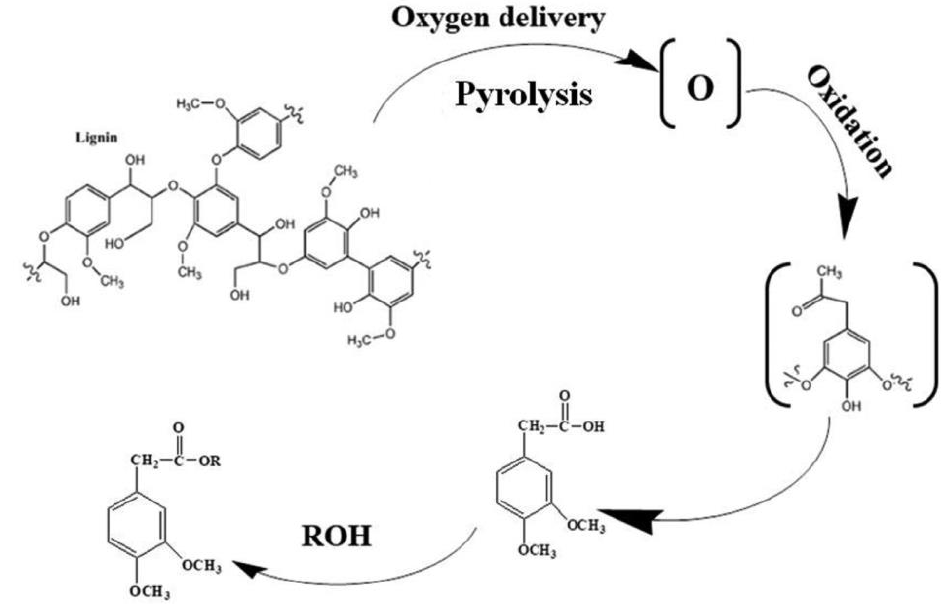
Figure 3. Esterification of lignin. Reproduced from [94], with the permission of Elsevier. Xing et al. [35] reported the esterification of soda lignin with 10-undecenoyl chloride and oleoyl chloride, carried out at 65 ◦ C for 48 h without additional use of solvents or catalysts. At the end of the reaction, methanol was added to the reaction to quench unreacted chlorides. After the removal of the solvent under vacuum, the products were dried in the vacuum oven for 24 h. Composites of poly(butylene adipate-co-terephthalate) (PBAT) with 10 and 20 wt.% of unmodified and modified lignin were obtained via extrusion in a twin-screw micro-compounder with a nitrogen purge. The extruded strands were then cut into pieces and subjected to pressure molding into thin films. The obtained films were subjected to UV irradiation to assess their UV-absorption capacity. Undecenoyl-treated lignin was found to have a higher UV-absorption capacity, while oleoyl-modified lignin showed better thermal stability. Modification of lignin with undecenoyl chloride resulted in better compatibility of the filler with the PBAT matrix, improved mechanical properties of the composites, and only slightly decreased thermal stability